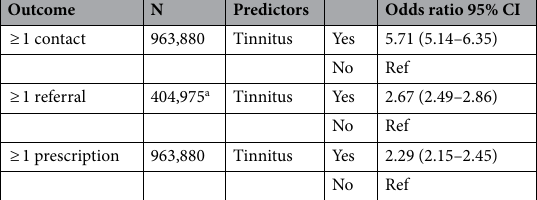
Table 3. Results of the logitisic regressions corrected for age and gender. a Perfomed in patients for whom referral data was available (404,975).